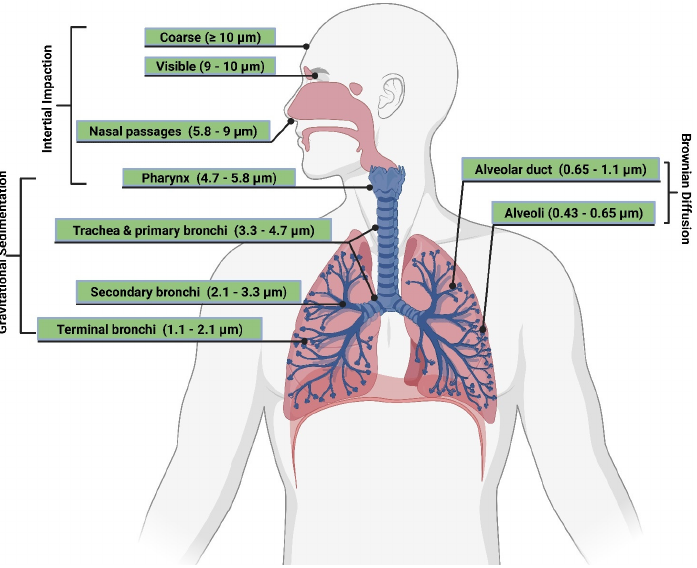
Figure 8. Inhaled particle sizes and respiratory deposition patterns. Mucociliary escalator and alveoli macrophages are the main causes of therapeutics inhalation failure, which is exacerbated during respiratory diseases. Although particles of MMAD between 1–5 µ m can evade the mucociliary escalator and deposit deep into the respiratory tract, they are rapidly engulfed by alveoli macrophages [192] (Figure 9). In order systems based on MMAD modulation can sustain drug release deep into the